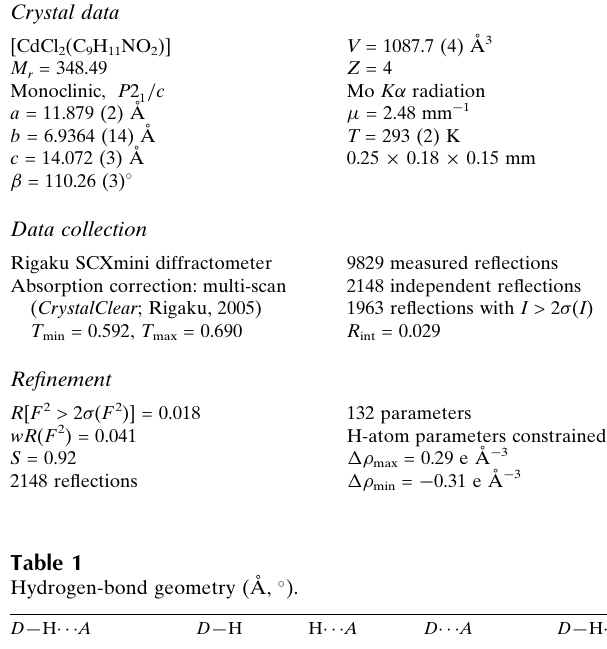
Rigaku SCXmini diffractometer Absorption correction: multi-scan